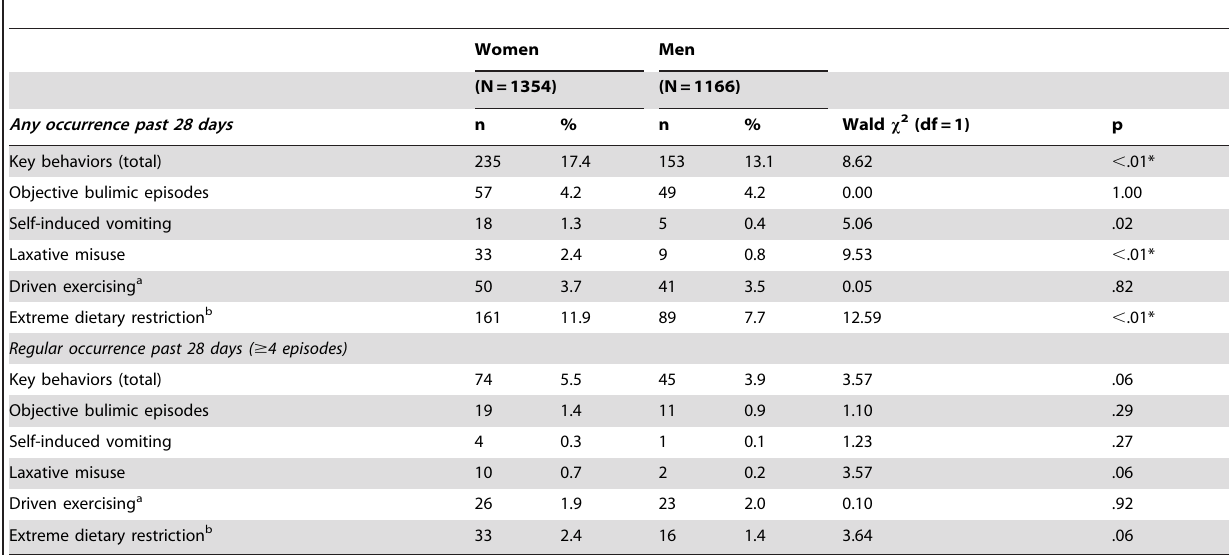
Table 2. Key Behavioral Features of the Eating Disorder Examination-Questionnaire (N